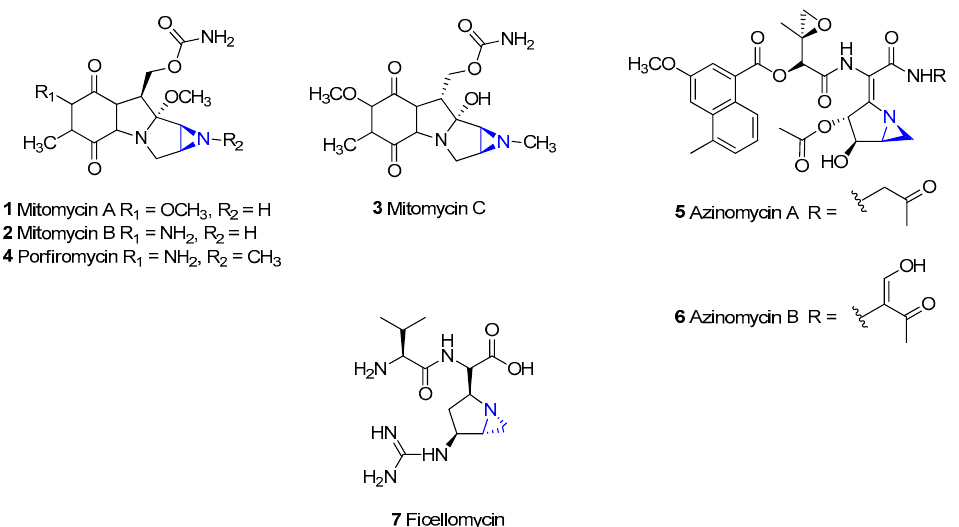
Figure 1. Structures of biologically active compounds bearing aziridine ring.